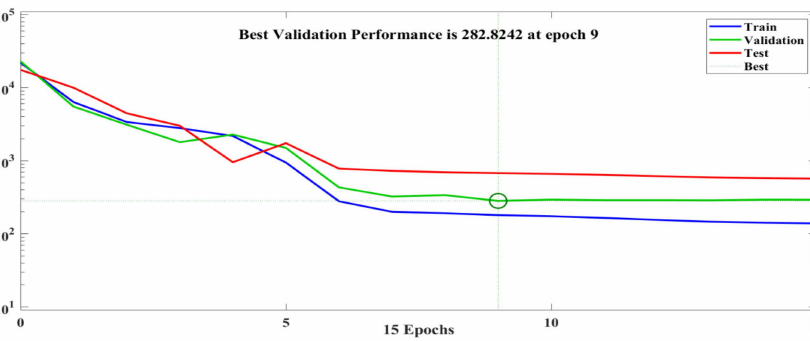
Figure 8. Leaning rate curve for TRANCE model performance with training, validation, and testing datasets.